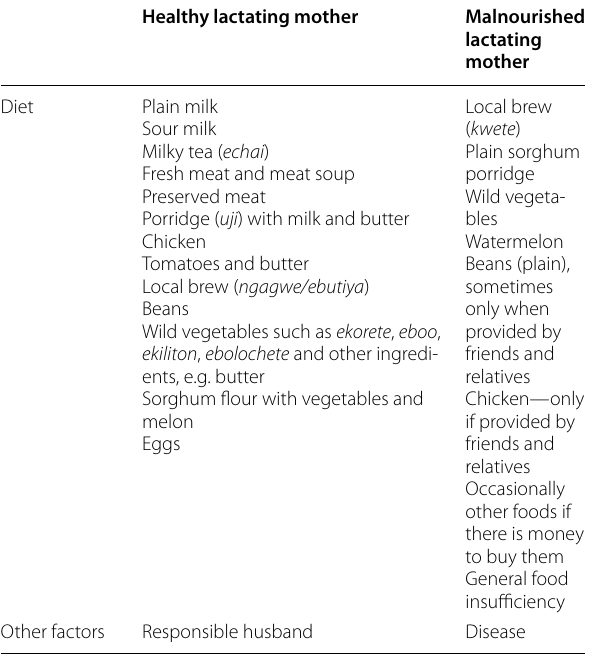
Table 4 Diets of healthy vs. malnourished lactating mothers Healthy lactating